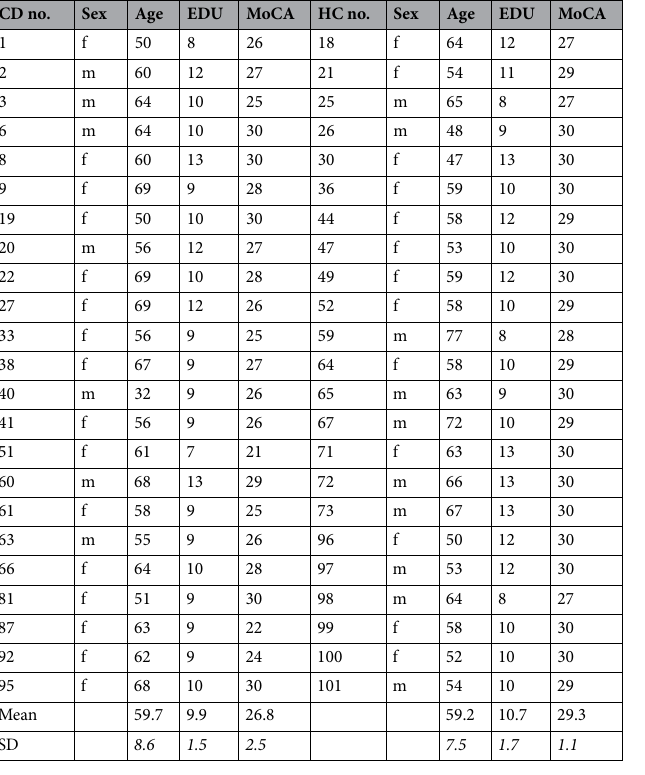
Table 2. Demographic data of cervical dystonia patients and healthy controls. CD: cervical dystonia, No.: number, EDU: educational level (in school years), HC: healthy controls, MoCA: Montreal Cognitive Assessment, f: female, m: male, SD: standard